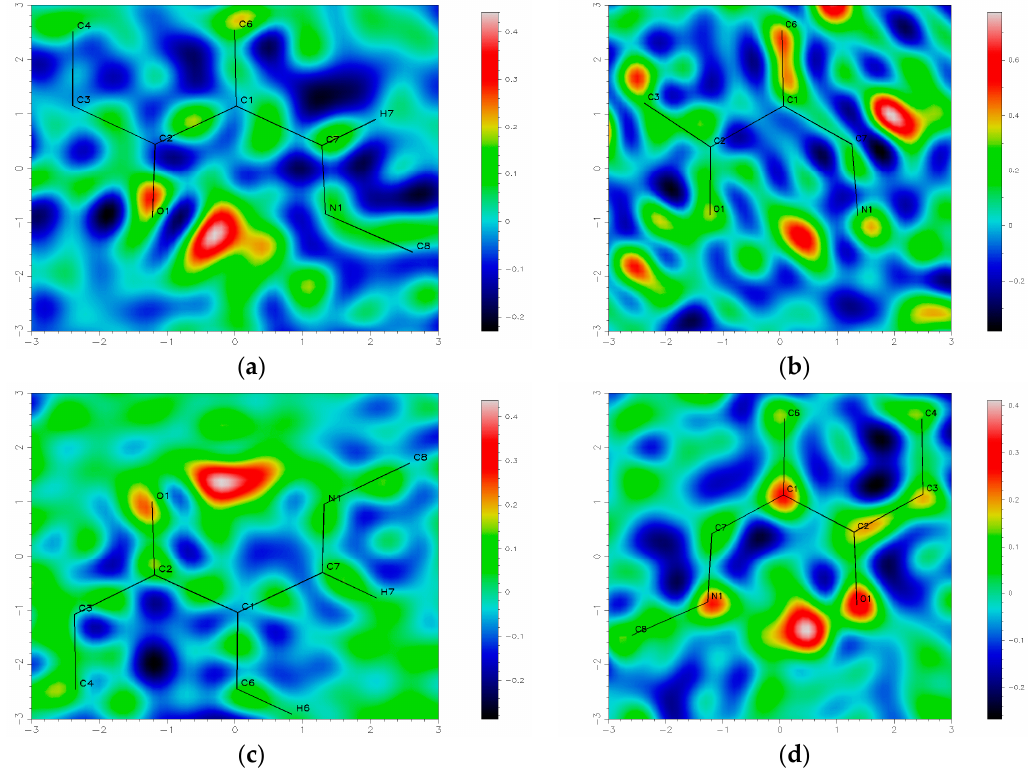
Figure B2. Contour δ F maps calculated through N1–C7–C1–C2–O1 chelate rings of ( a ) oOHsaladpm , ( b ) mOHsaladpm , ( c ) pOHsaladpm and ( d ) mvanadpm with pronounced maximum representing the residual electron density corresponding to the position of the H1 atom in the intramolecular H-bond.